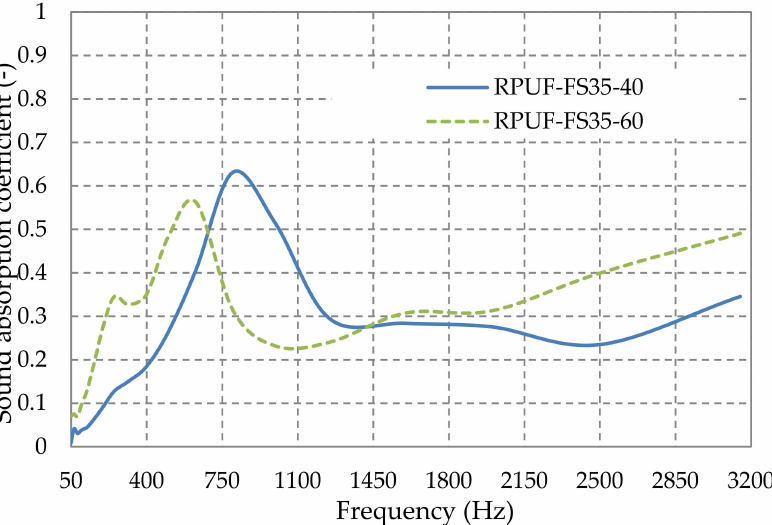
Figure 8. Sound absorption coefficient variation with plates thickness from rigid polyurethane foam with 35% fir